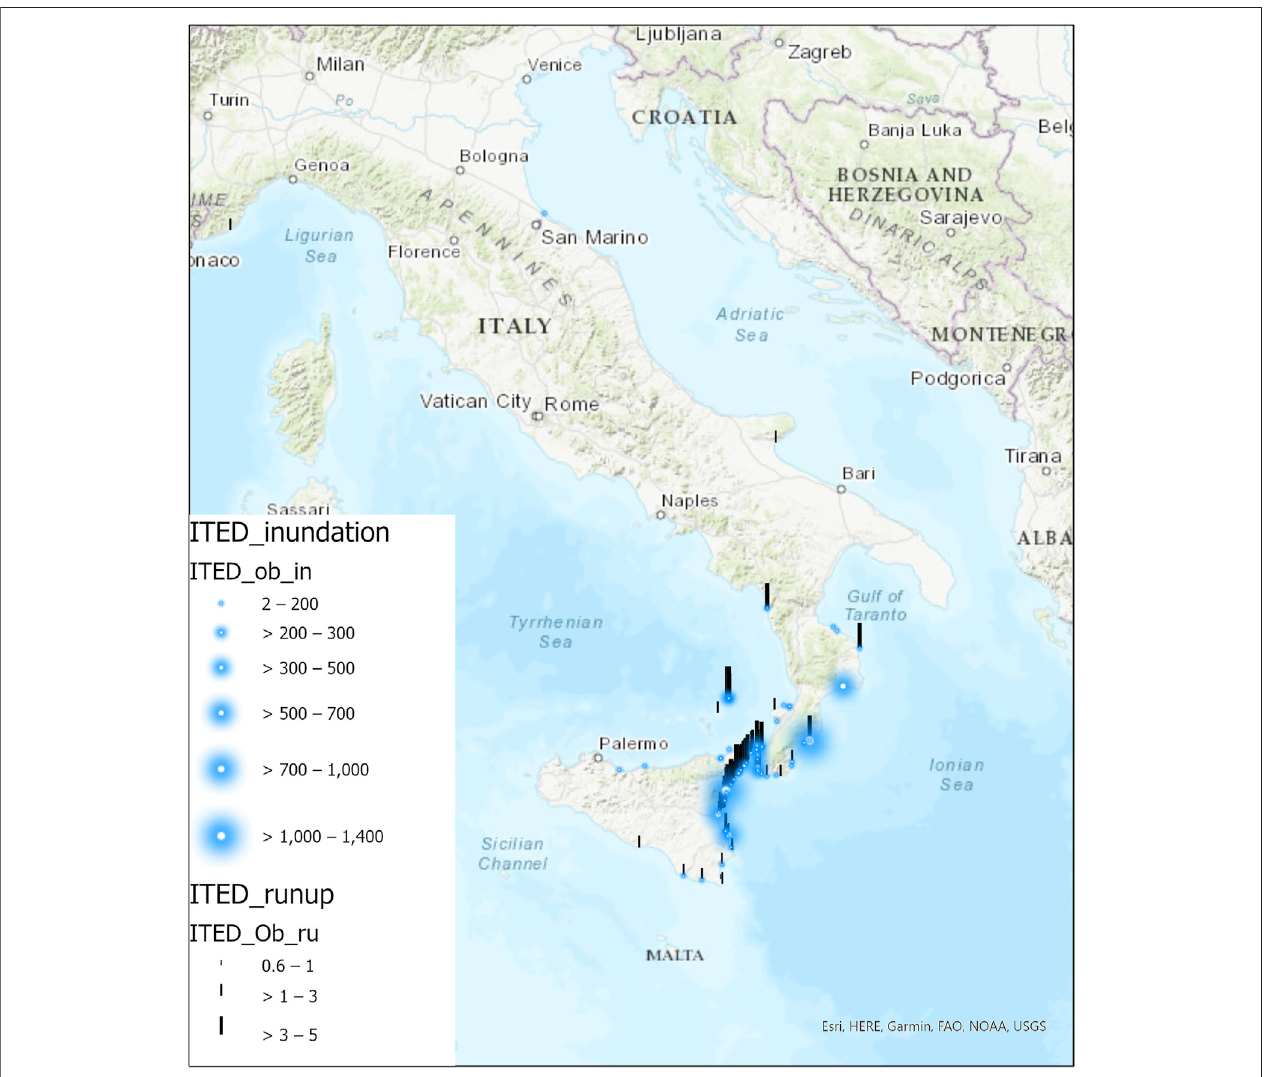
FIGURE3| ScreenshotoftheWebAppshowingITED_runup(blackbars)andITED_inundation(bluehalos)layers;symbolsareproportionaltothemeasuredvalues (Service Layer Credits: sources: ©Esri, HERE, Garmin, Intermap, increment P Corp., GEBCO, USGS, FAO, NPS, NRCAN, NOAA, GeoBase, IGN, Kadaster NL, Ordnance Survey, Esri Japan, METI, Esri China (Hong Kong), ©swisstopo, ©OpenStreetMap contributors 2019. Distributed under a Creative Commons BY-SA License).